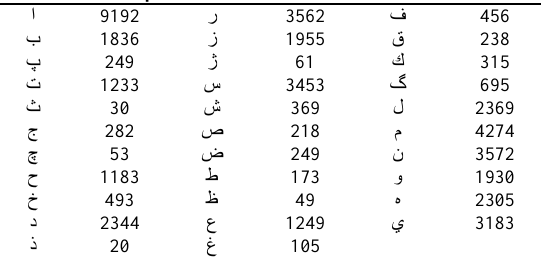
Table 1.The dispersion of characters in selected database. ﺍ